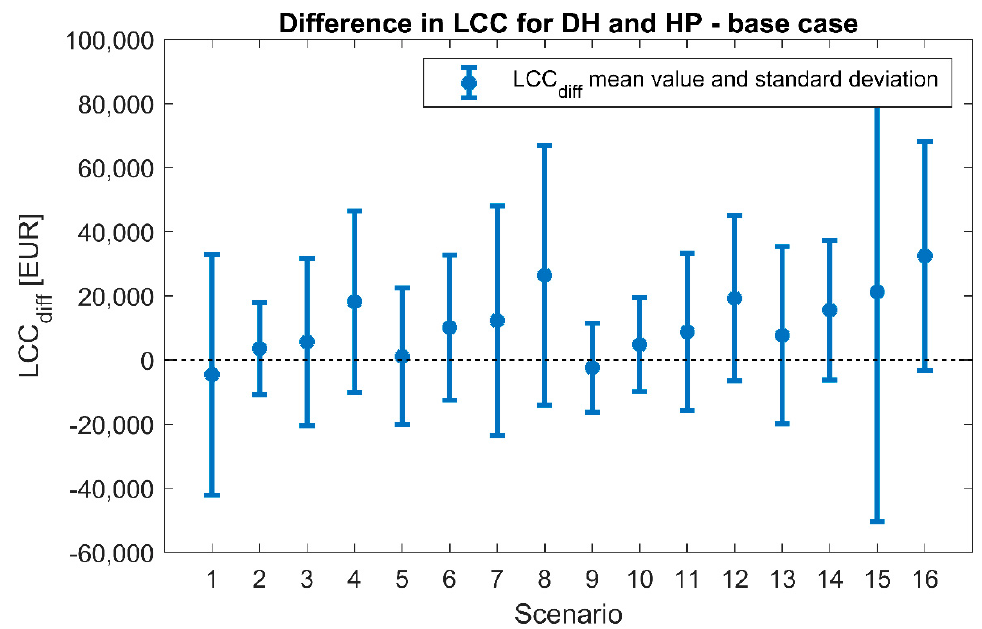
Figure 4. The LCC diff mean value and standard deviation. The points below the dashed line are negative values, i.e., the DH case is cheaper.